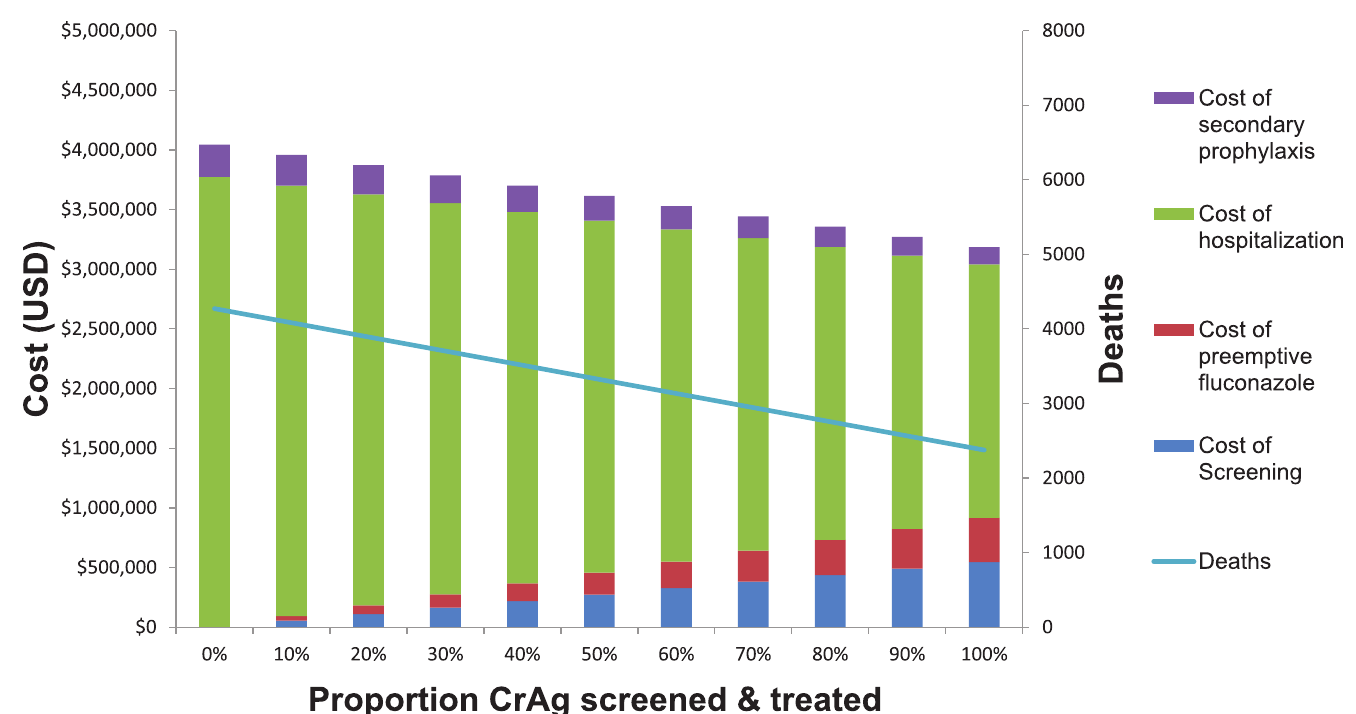
Fig 6. Cost of CrAg screening and preemptive treatment with differential levels of implementation. With 100% CrAg screening and treatment, 1900 lives are saved (44%) and $860,000 dollars, compared to no screening. Even with a small increase in CrAg screening from 0 to 10%, there are cost savings and deaths averted.